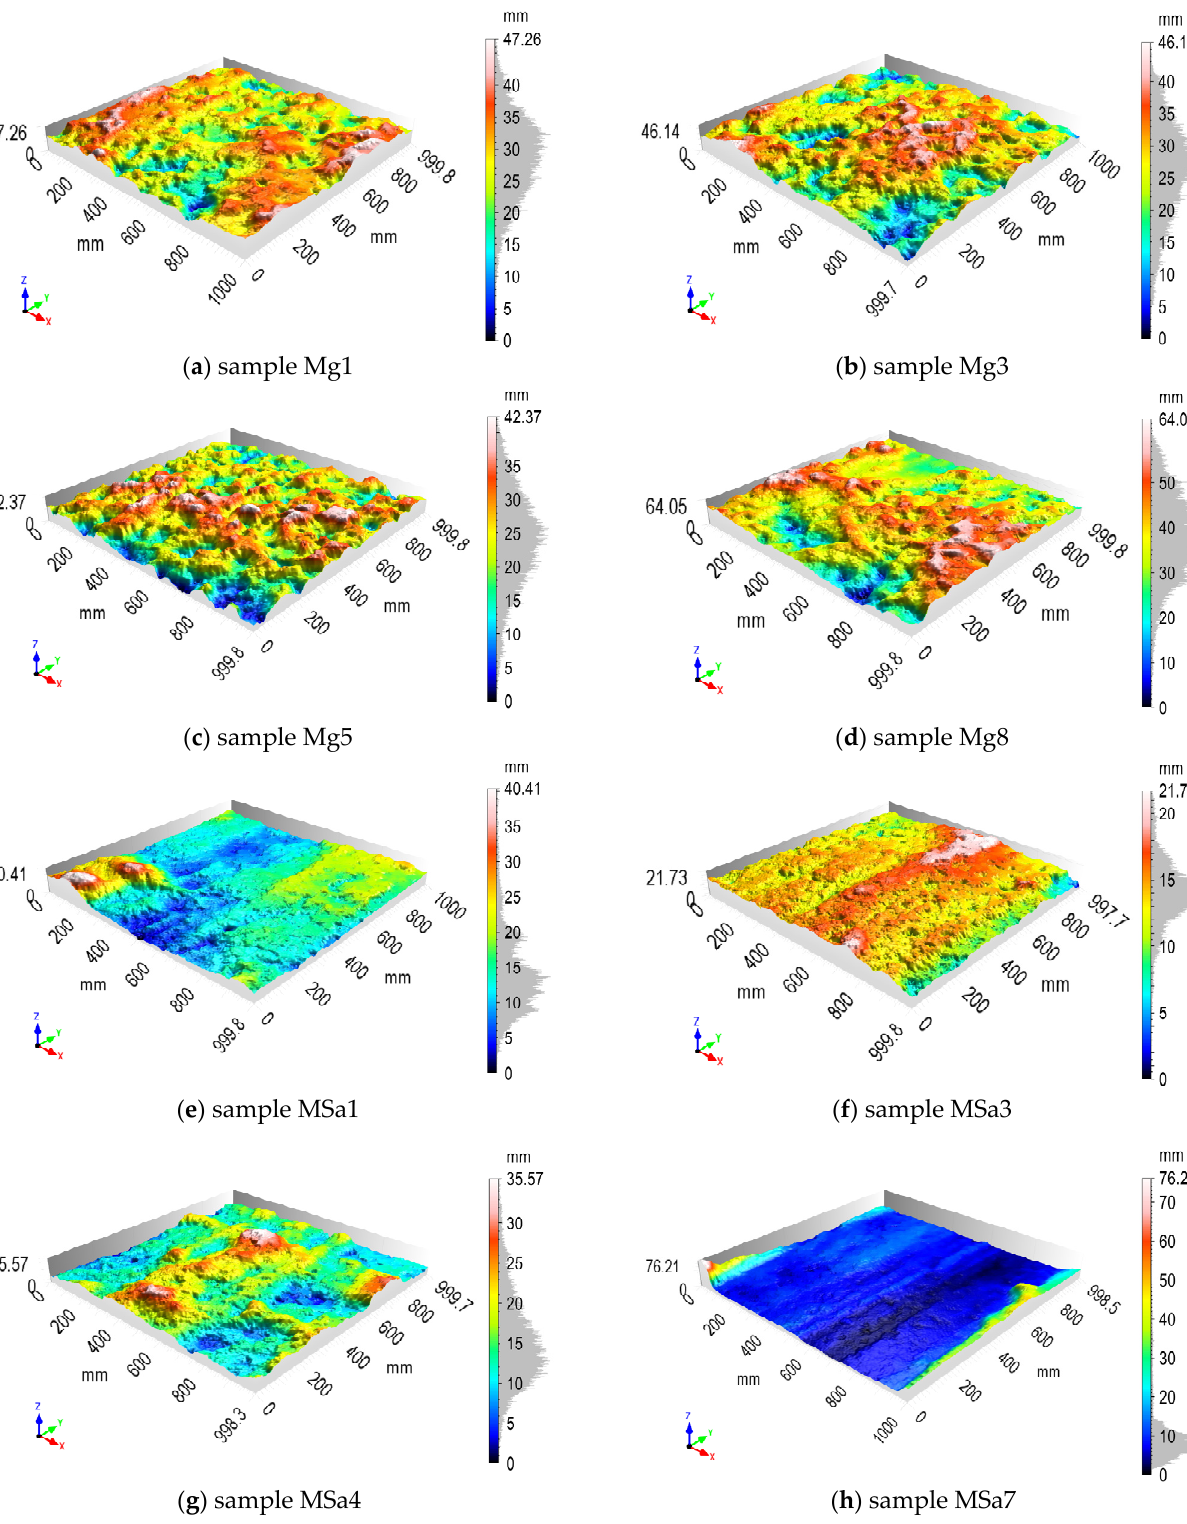
Figure 12. Results of diaphragm wall surface processing for chosen samples: ( a – d ) from anthropogenic soil; ( e – h ) from medium sand.